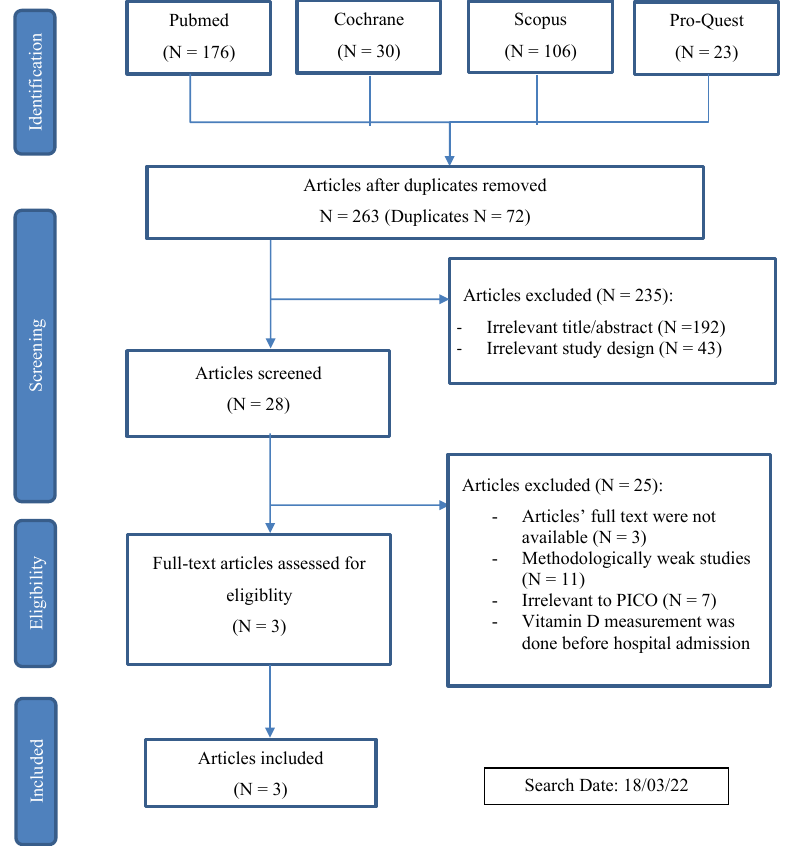
Figure 1. Prisma’s flow